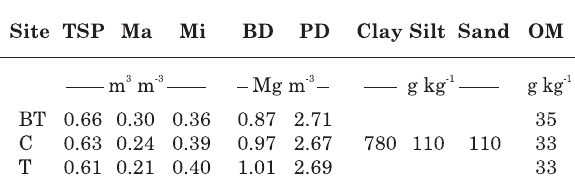
Table 1. Soil physical properties of the